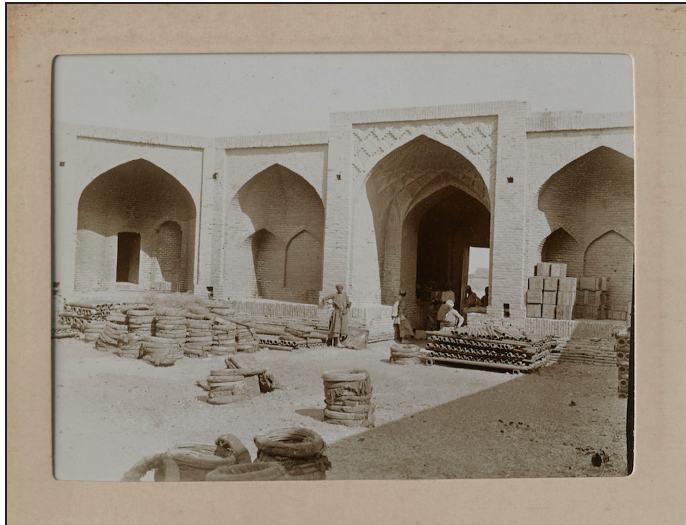
Fig. 4 : Caravanserai at Kabuter Khana, with telegraph material. Photograph by Herbert Sykes, Sykes Family